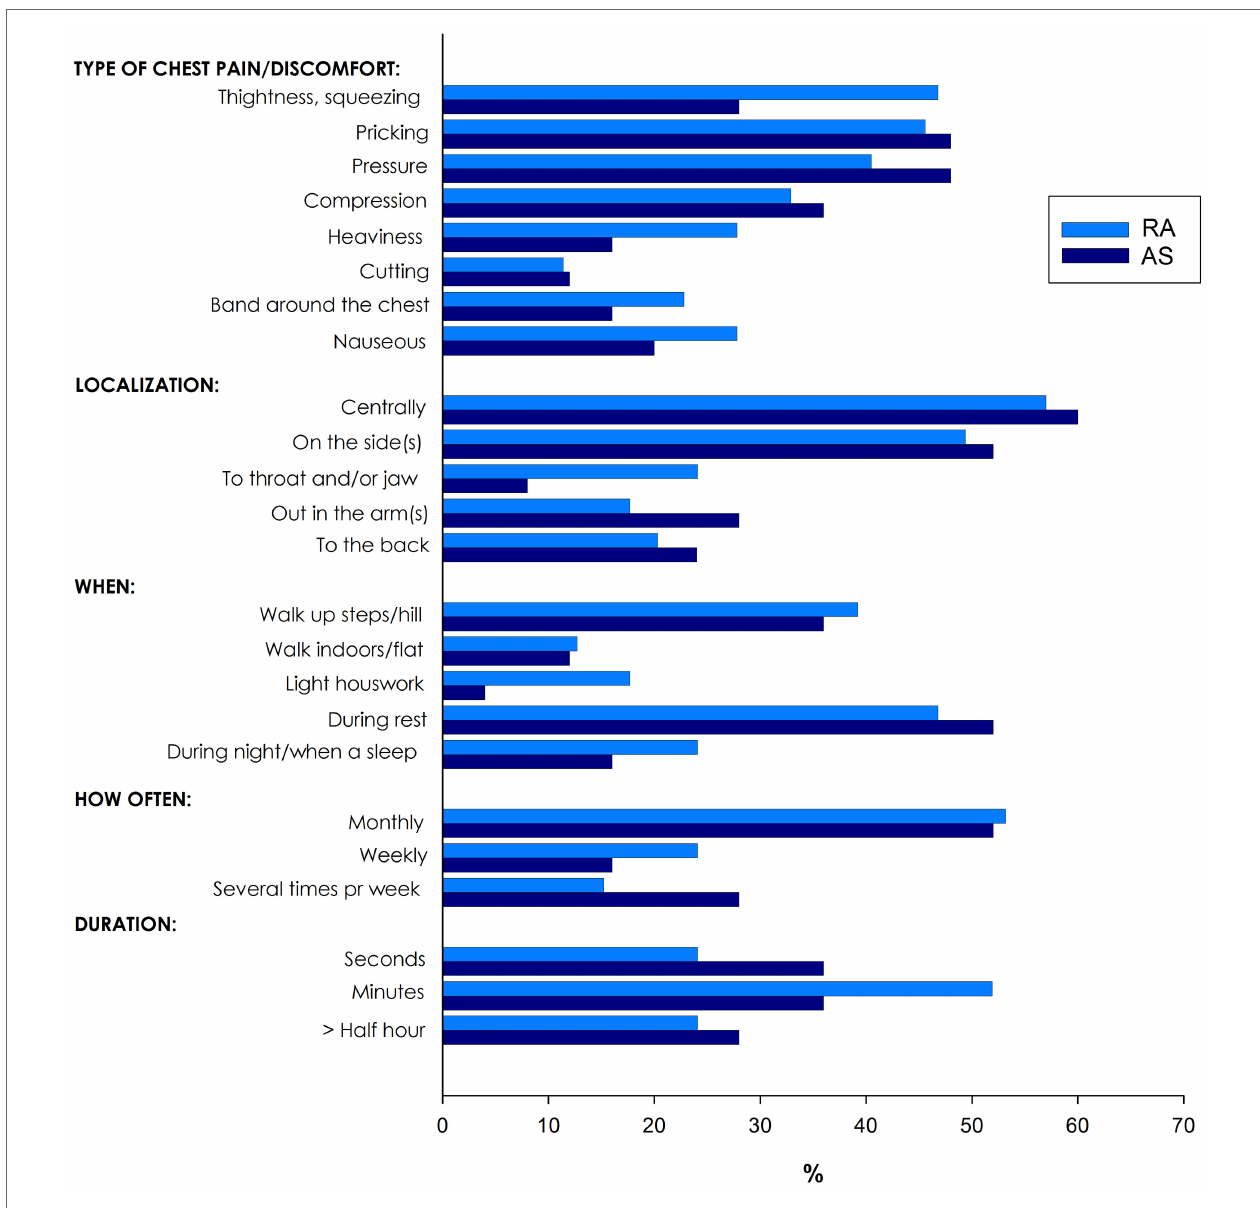
FigUre 1 | Various types of chest pain in patients with rheumatoid arthritis (ra) and ankylosing spondylitis (as)